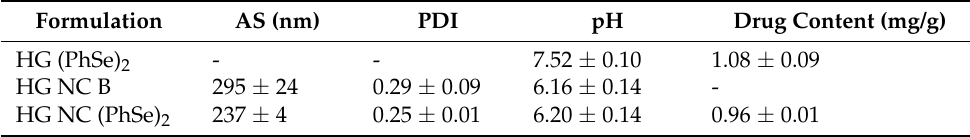
Table 1. Physicochemical characteristics of the developed formulations.